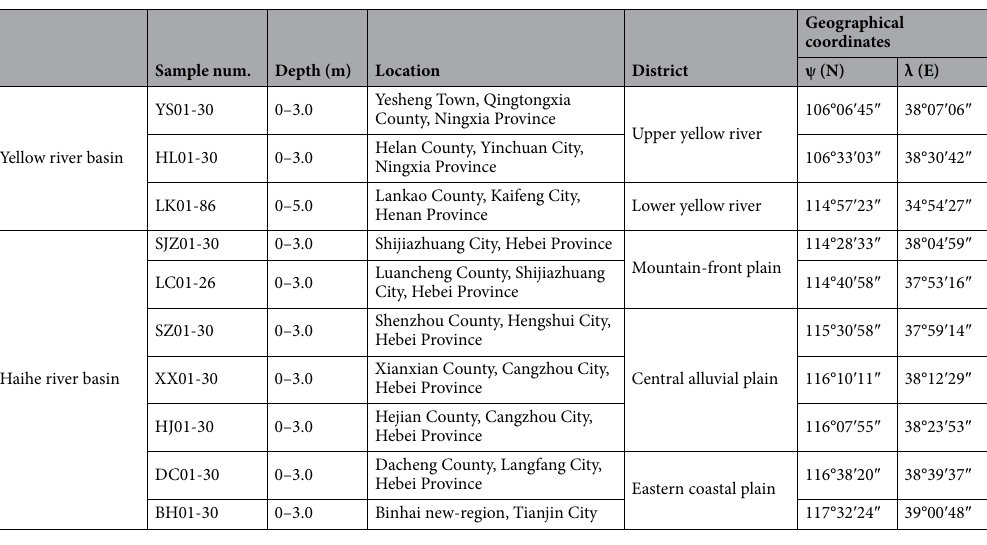
Table 1. The description of sampling